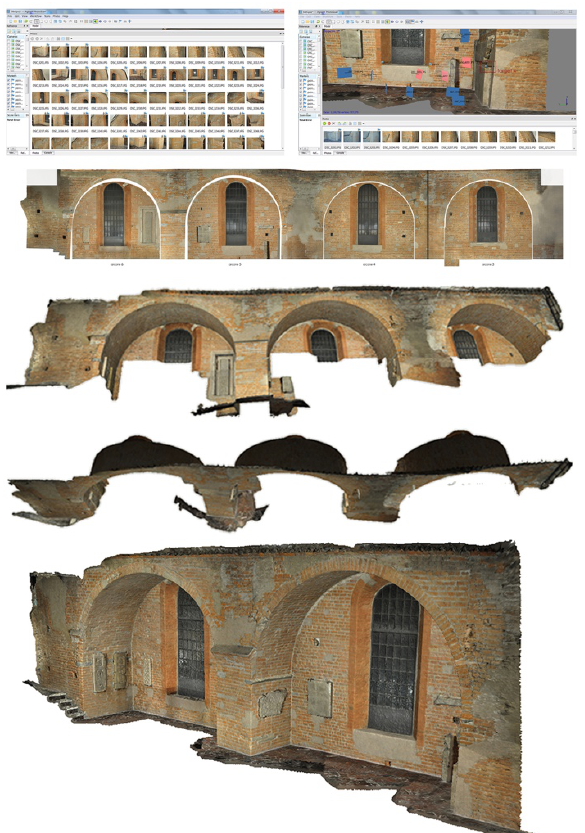
Figure 5. The orthophotos were used as the basis for geometric and building archaeology